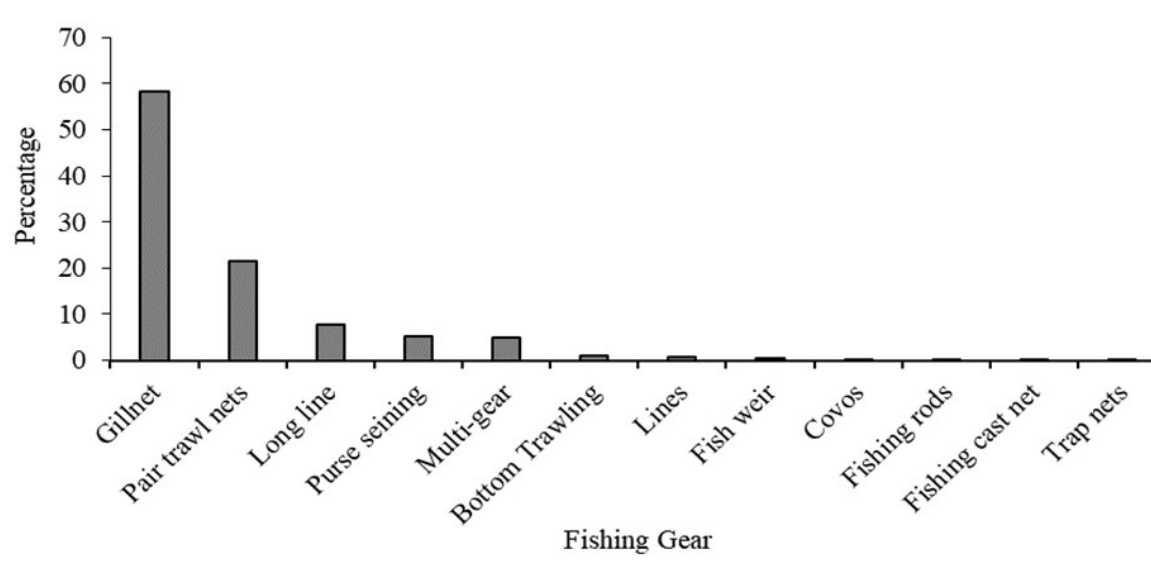
Figure 4. Contribution by fishing gear on the landed volume of marine catfish ( Genidens barbus ) from 2000 to 2014 on the São Paulo